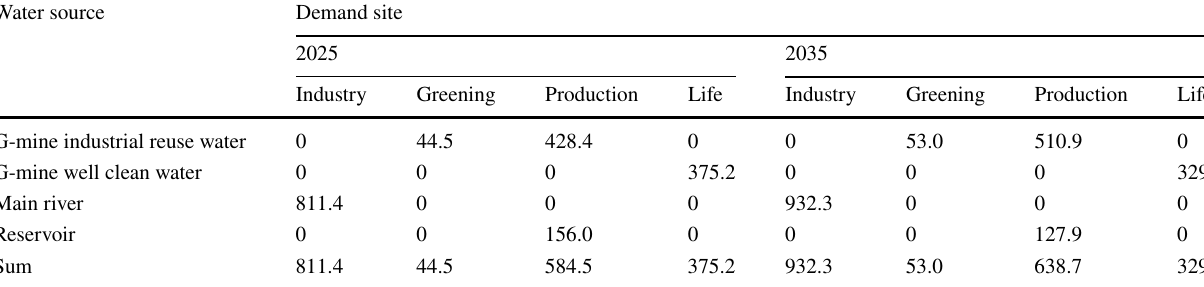
Table 11 Results of water resources allocation in the g-mine area in 2025 and 2035